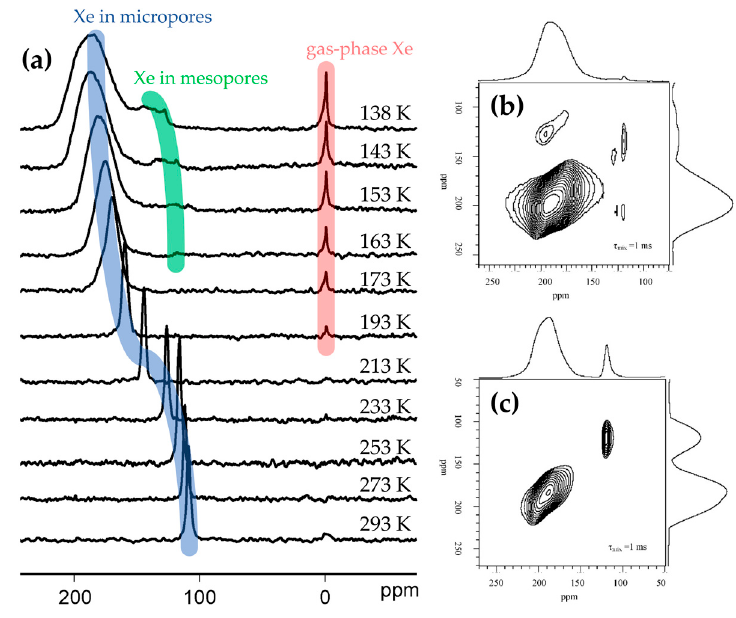
Figure 9. 129 Xe-NMR of Meso-ZSM-5 (50) between 293 and 138 K, showing the presence of Xe with different spatial constraints ( a ). Laser-hyperpolarised 129 Xe 2D-EXSY NMR with a mixing time of 1 ms of Meso-ZSM-5 (50) at 143 K ( b ). Off-diagonal signals are due to Xe transferring between micropores ( δ ~200 ppm) and mesopores ( δ ~120 ppm). Laser hyperpolarised 129 Xe 2D-EXSY NMR of a physical mixture of microporous ZSM-5 and mesoporous silica at 143 K, with a mixing time of 1 ms ( c ). A lack of off-diagonal peaks indicates slower diffusion of Xe between the micropores ( δ ~200 ppm) and mesopores ( δ ~120 ppm) (modified from reference [92]).